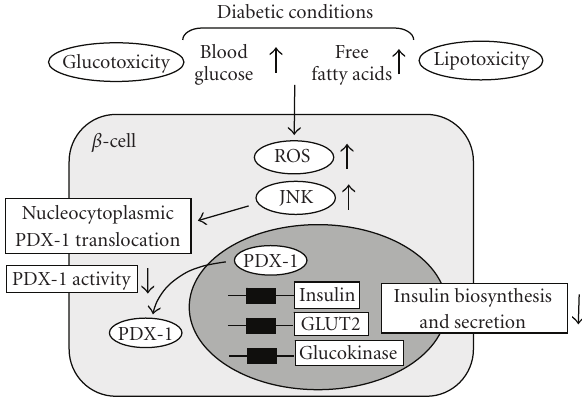
Figure 2: Role of ROS in the progression of pancreatic β -cell dysfunction in type 2 diabetes. ROS are provoked by hyperglycemia and/or hyperlipidemia under diabetic conditions, which leads to activation of the JNK pathway in pancreatic β -cells. ROS and subsequent activation of the JNK pathway induce nucleo- cytoplasmic translocation of PDX-1, which leads to reduction of PDX-1 activity and suppression of insulin. Therefore, it is likely that ROS and activation of the JNK pathway are involved in β -cell dysfunction found in type 2